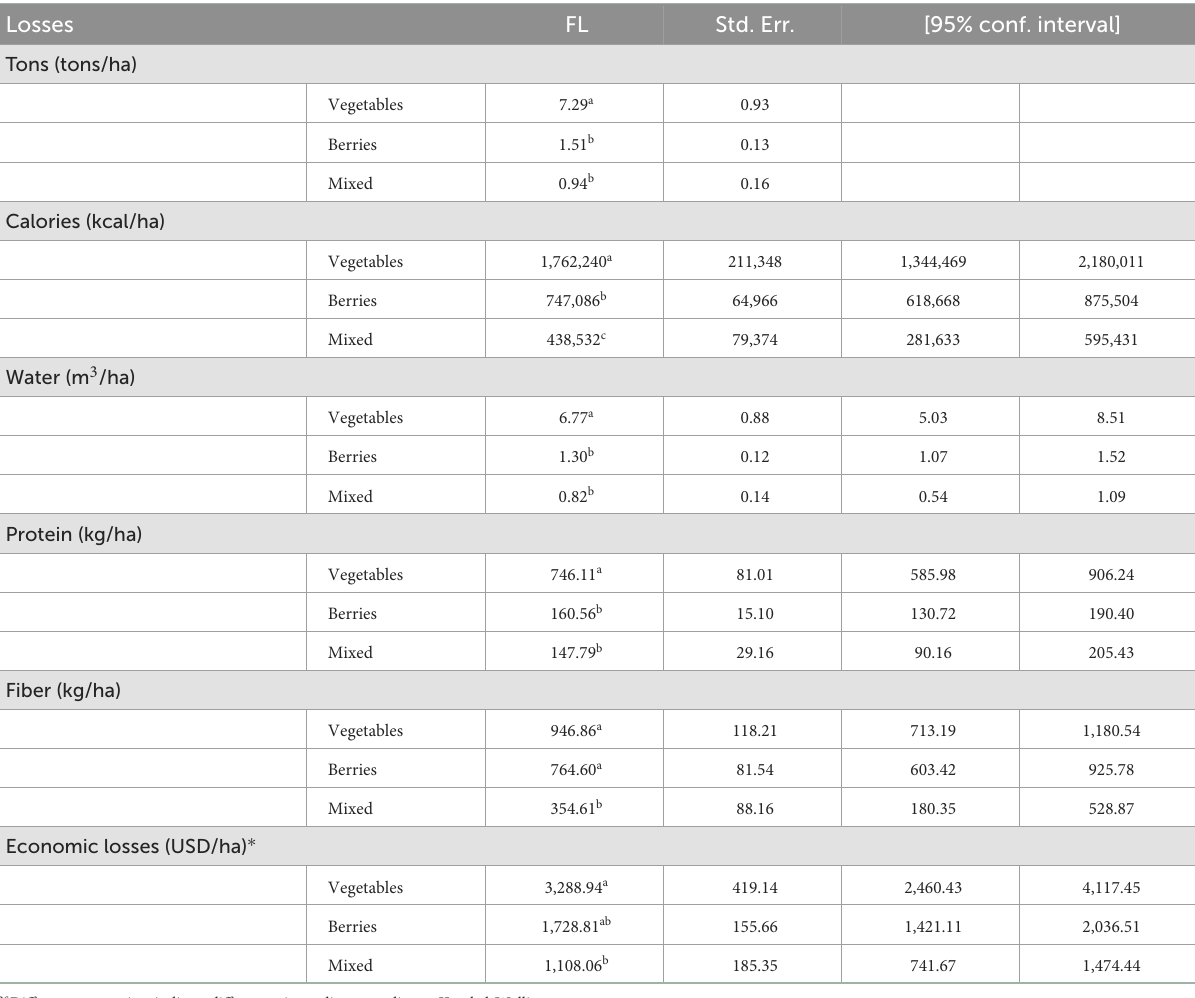
TABLE 3 Mean differences of food loss (FL) in tons, and nutritional and economic losses, calculated according to productive systems (vegetables = 56 obs.; berries = 66 obs., mixed = 22 obs).